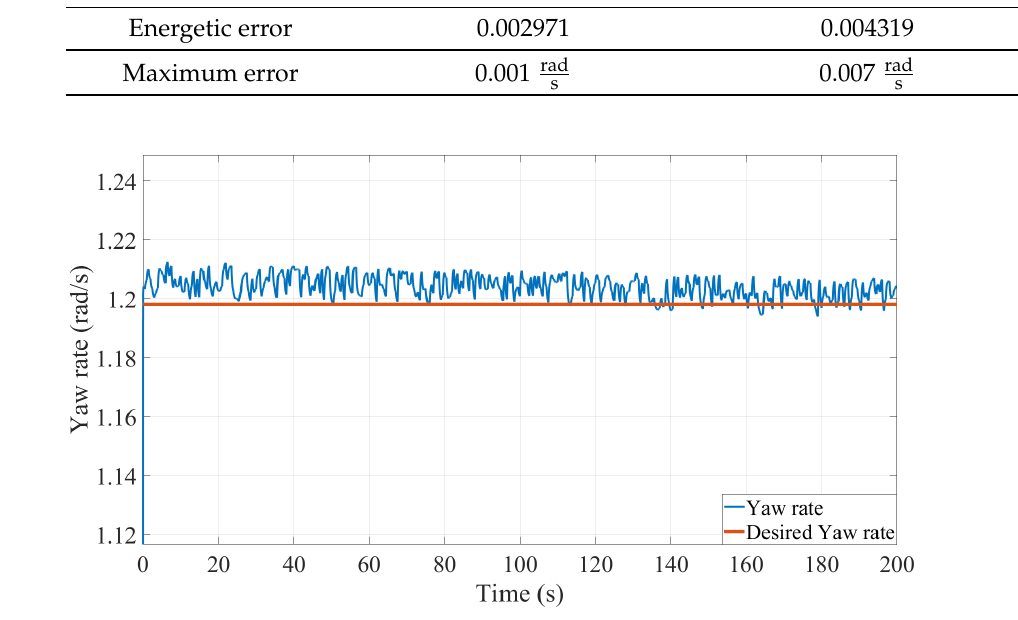
Figure 22. STA with underestimated value.